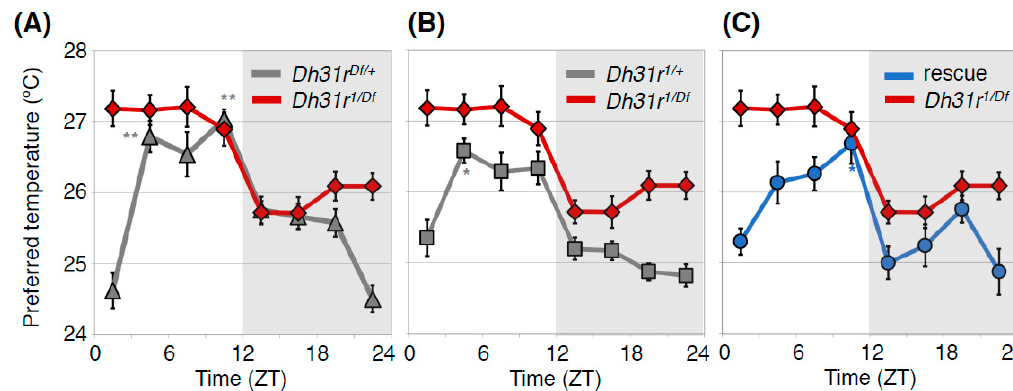
Figure 4. DH31R regulates the daytime TPR. Comparison of TPR between Dh31r mutant flies ( Dh31r 1 / Df , red line in ( A – C ) and heterozygous control flies ( Dh31r 1 /+ , gray line in ( A ) or Dh31r Df /+ , gray line in ( B )) or Dh31r genomic rescue flies (rescue, blue line in ( C )). Dh31r mutant flies show an abnormal daytime TPR, in which they prefer a constant temperature of approximately 27 ◦ C during the daytime. The control flies exhibit a normal daytime TPR, in which their preferred temperature increases during the daytime ( A , B ). Genomic rescue of Dh31r flies restored normal daytime TPR ( C ). Dh31r 1 is a P-element insertion mutant ( PBac {WH}Dh31-R f05546 ), and Dh31r Df is a deletion mutant [ Df(2R) BSC273 ]. In the Dh31r genomic rescue fly, the Ch321-57F06 BAC clone, which includes the entire Dh31r gene region, is inserted into the genome. The graphs are modified from Goda et al. 2018, Figure 1 [23]. *: p < 0.05, **: p < 0.01 (comparison to ZT 1 – 3).